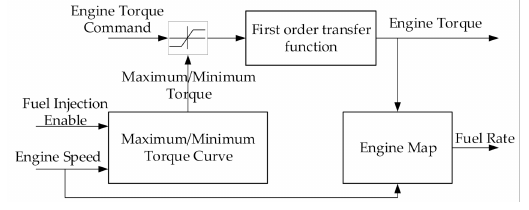
Figure 2. Engine